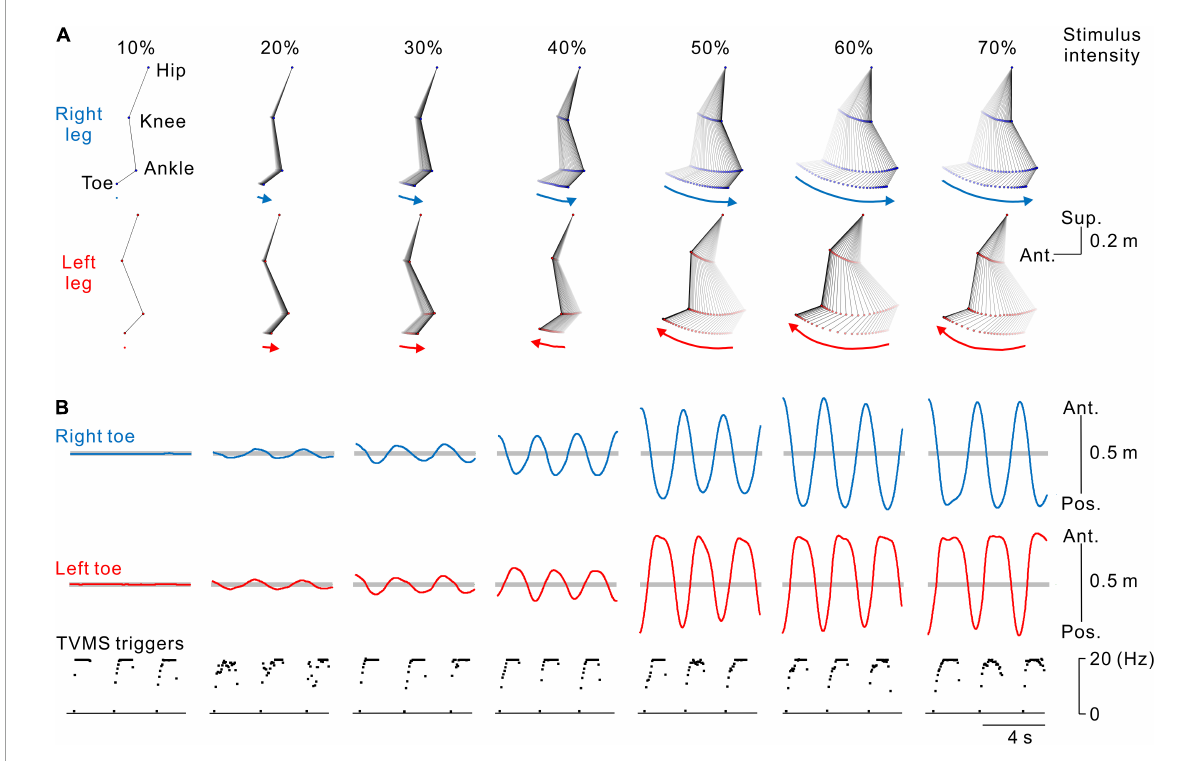
FIGURE2 Kinematics of stimulus-evoked leg movements. (A) Stick pictures showing examples of right (blue) and left (red) leg movements evoked by transvertebral magnetic stimulation (TVMS) at different stimulus intensities in a single participant. From left to right, stimulus intensity of 10% to 70% maximum stimulator output (MSO). Arrows below the stick pictures indicate the direction of the induced leg movement at the timing of the stimulus trains. (B) Traces showing the movement trajectories of the right (blue lines in the top row) and left (red lines in the middle row) toes in the antero-posterior axis and spinal stimulation (bottom row). Horizontal gray areas behind the toe movement traces represent the ranges between ± 5 standard deviations of toe movements calculated during the baseline period of 2 s before the beginning of